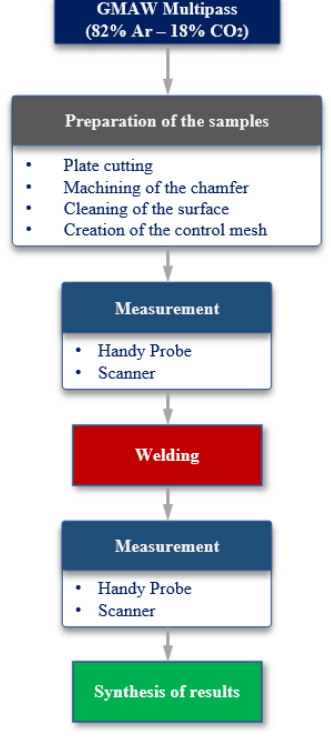
Figure 5. Methodology flowchart.